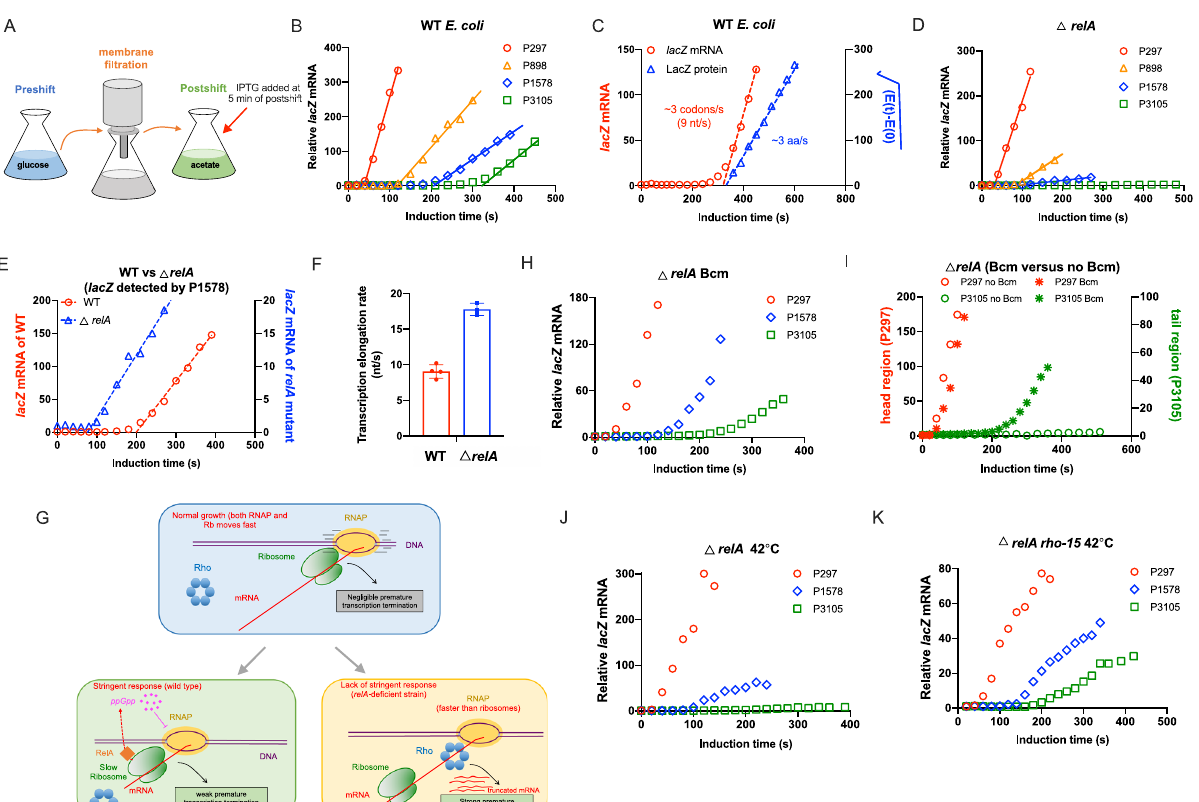
Fig.7|(p)ppGppassiststranscription-translationcoordinationin E.coli during carbon downshift. A Schematic illustration of the experimental